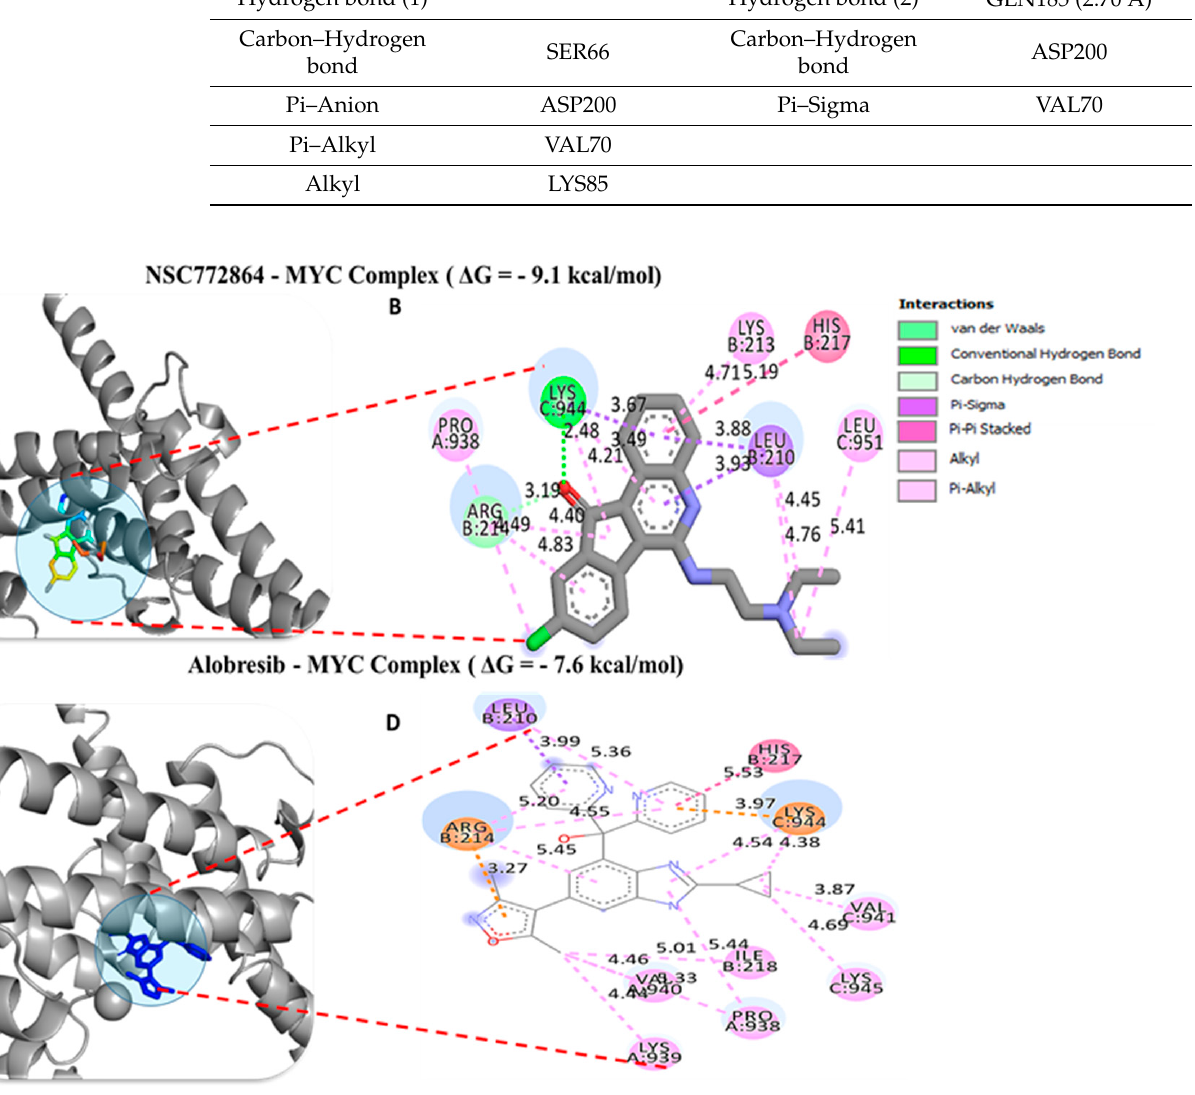
Figure 14. Docking profiles of c-MYC with NSC772864 and standard inhibitors. ( A , B ) NSC772864 bound with c-MYC with Gibbs’ free energy ( Δ G) of − 9.1 kcal/mol. ( C , D ) Binding of crizotinib with c-Met showed a slightly higher affinity of ∆ G = − 7.6 kcal/mol compared to NSC772864. Table 5 gives binding energies of ligand–receptor interactions, including different types of interactions and the amino acid residues involved. Table 5. NSC772864 and standard drug comparative docking profile against c-MYC.